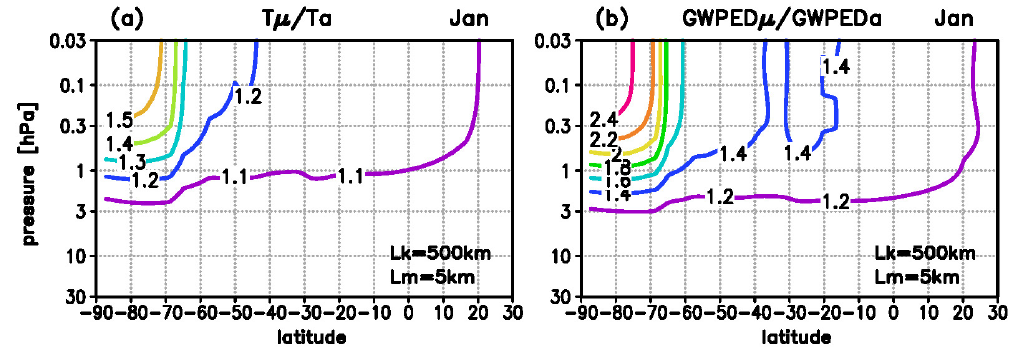
Figure 5. Cumulative amplifications of the GW amplitude during the upward level-by-level propagation for a GW with L k = 500km and L m = 5km, (a) Cumulative increase in the temperature amplitudes described by T µ /T a . (b) Related increase in the gravity wave potential energy density (GWPED) described by E µ /E a ; background conditions: January 2001.